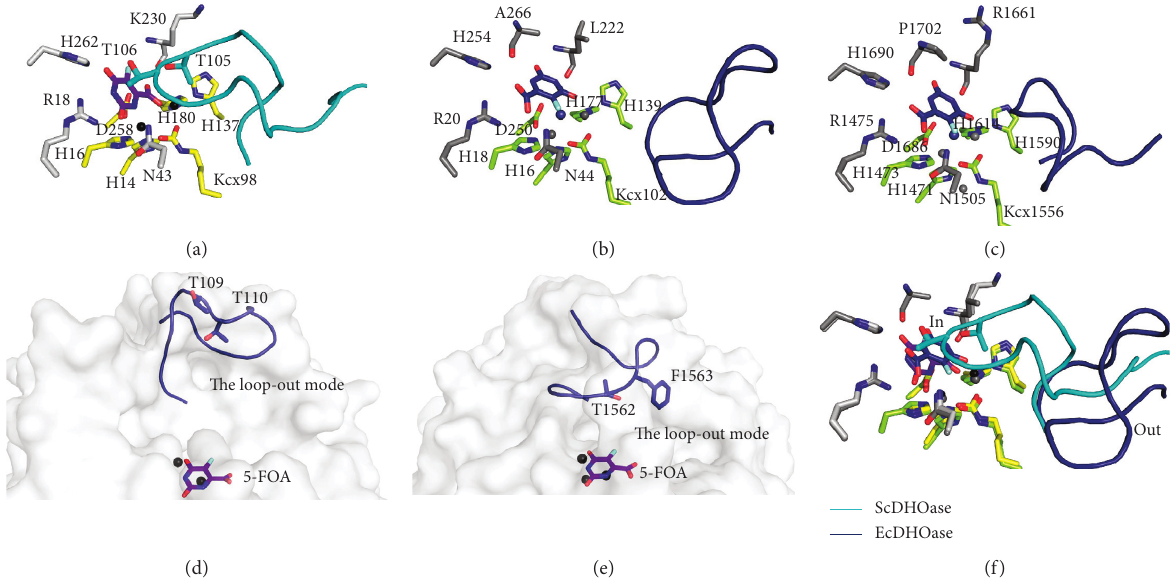
Figure 3: New binding mode of 5-FOA. (a) The active site of ScDHOase with 5-FOA. (b) The active site of EcDHOase with 5-FOA (PDB entry 2EG8). The binding mode of 5-FOA to the active site is very similar to that of DHO. (c) The active site of huDHOase with 5-FOA (PDB entry 4C6M). By comparison, the bound 5-FOA by ScDHOase adopted the reverse orientation as compared to that in the active site of EcDHOase and huDHOase. (d) The loop-out binding mode of EcDHOase. (e) The loop-out binding mode of huDHOase. The flexible loop in EcDHOase and huDHOase is not involved in the binding of 5-FOA. (f) Superposition of the ScDHOase and EcDHOase complexes. Despite having a similar active site, the 5-FOA binding pose and the conformation of the catalytic loop of ScDHOase differ from those of